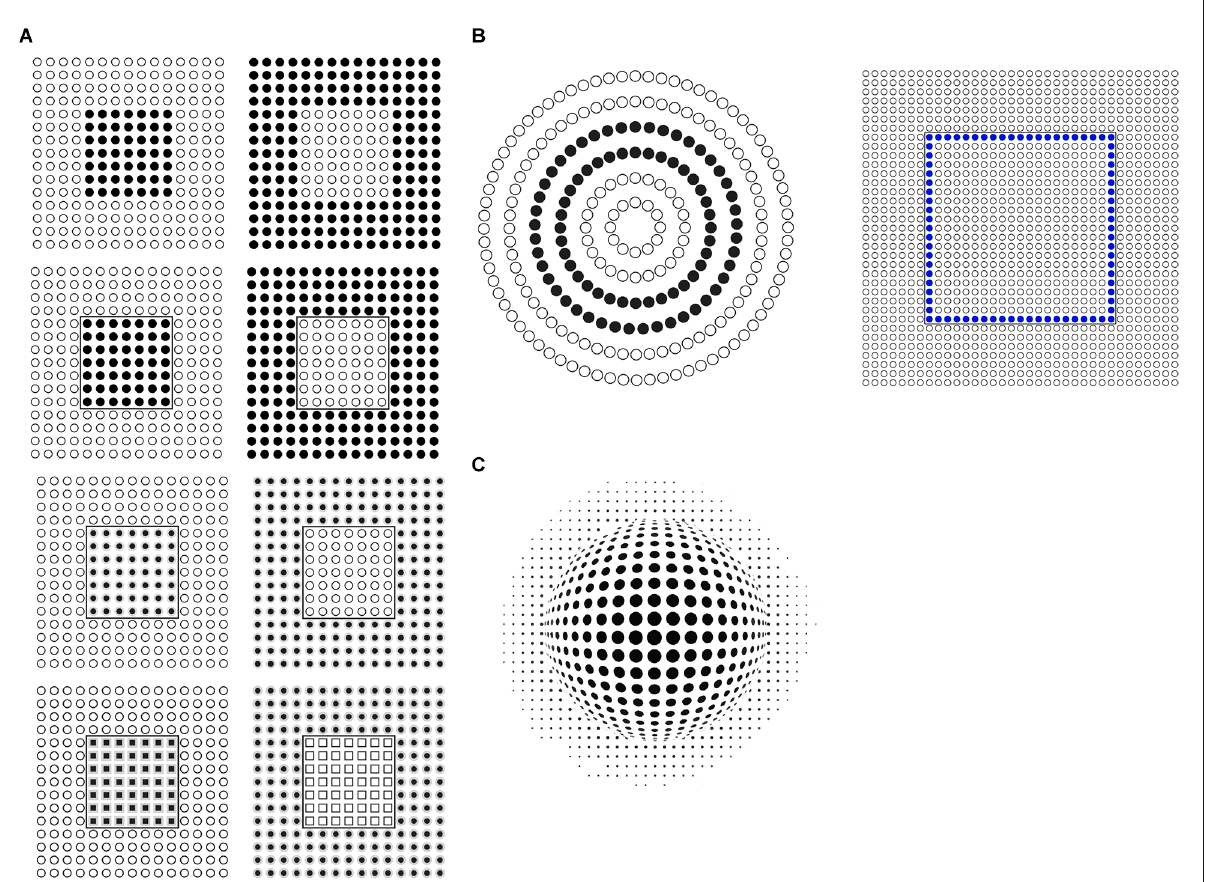
FIGURE18 (A) Apparent floating motion increases with increasing the strength of the figure-ground segregation imparted by the similarity/dissimilarity of the inset/surrounding elements. (B) Apparent floating motion of the filled elements. (C) Apparent floating motion of the emerging sphere.